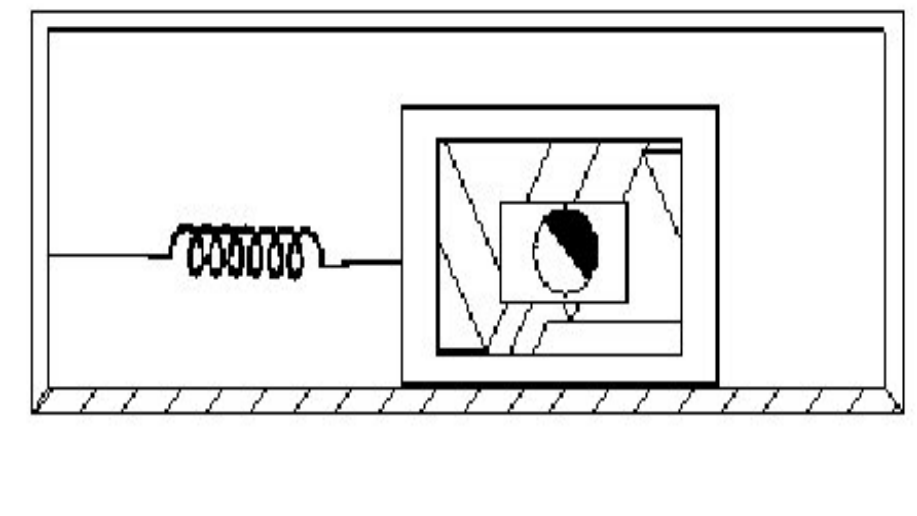
Figure 1. Basic spring-mass system